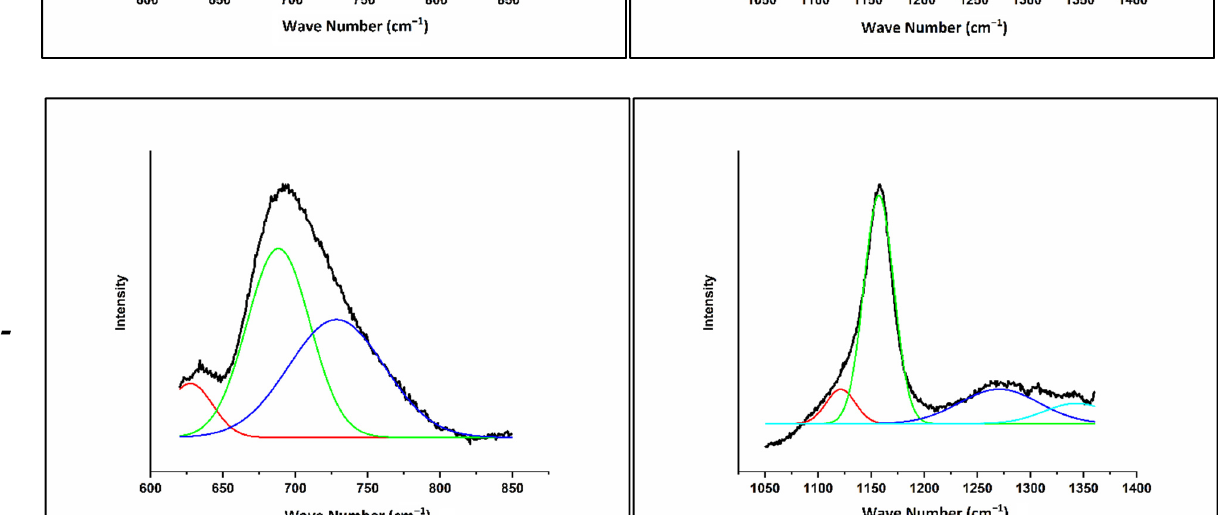
Figure 4. Deconvoluted Raman spectra for concentrations of [K 2 O/(CaO+MgO)] ratio (%mol). ( a ) VF1: 0.67 %mol, ( b ) VF2: 1.33 %mol and ( c ) VF3: 2 %mol in the regions 620–850 cm − 1 and 1050–1360 cm − 1 .